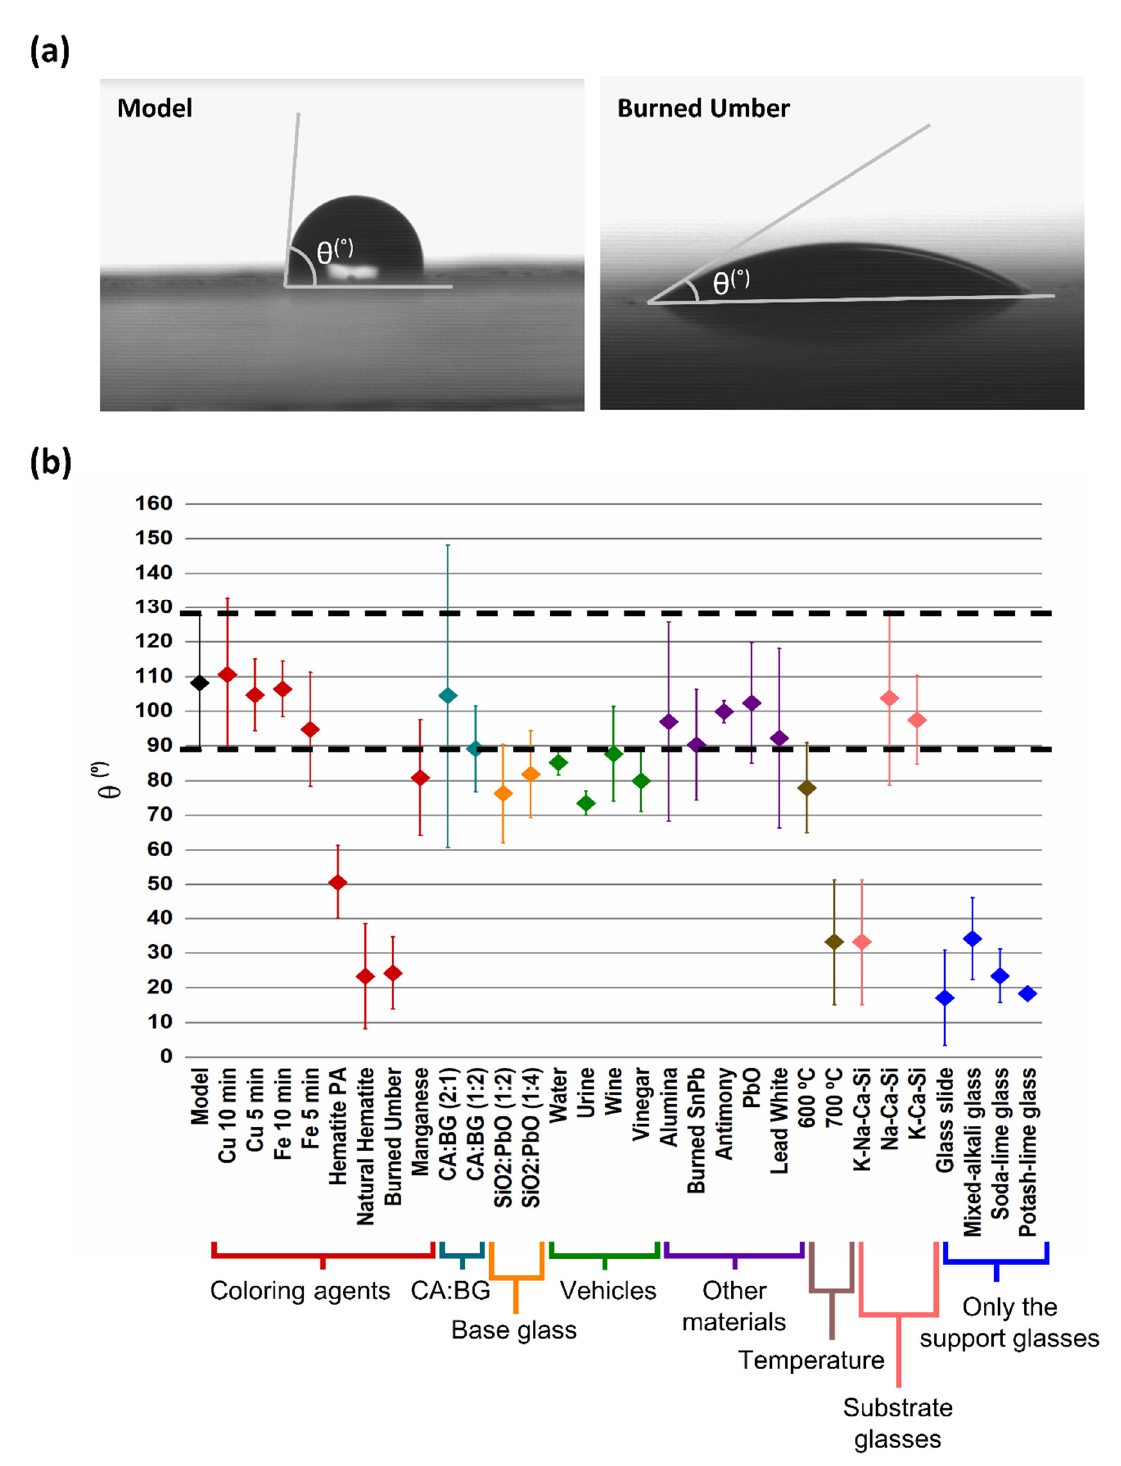
Figure 4. Contact angle results ( a ) examples of pictures taken during the test and ( b ) graphical representation of contact angle for all the samples (model sample in black).